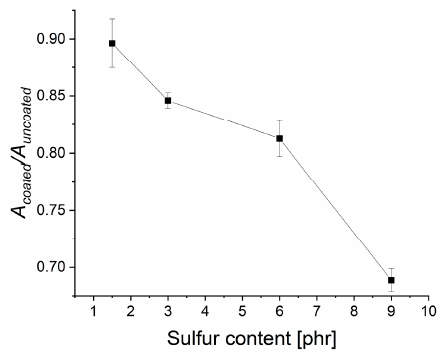
Figure 14. Ratio of contact area for coated and uncoated samples at various sulfur content.